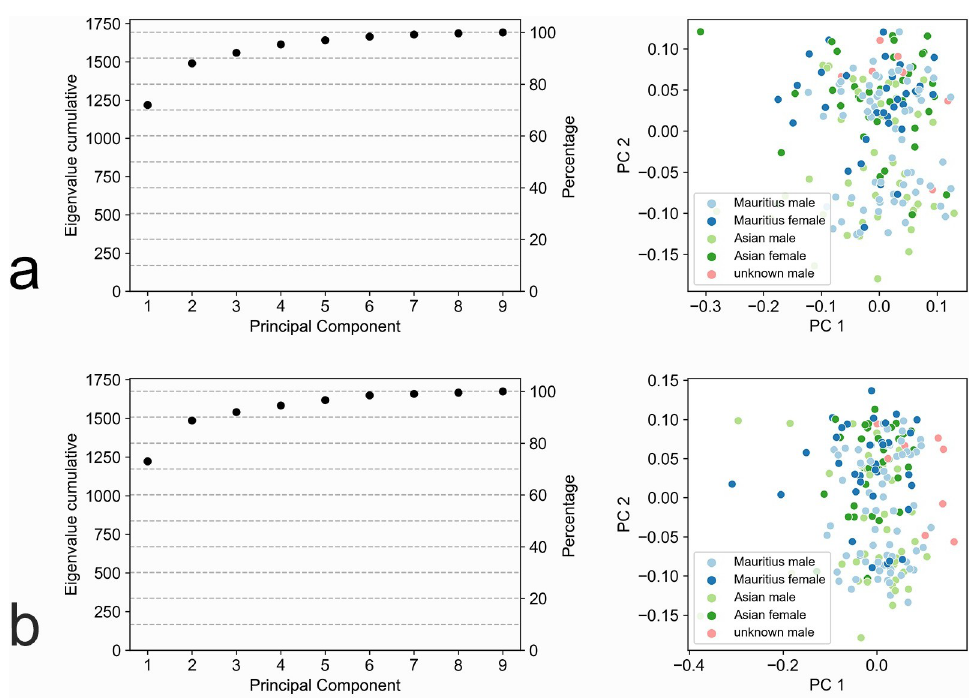
Fig 5. Principal Component Analysis (PCA) plots of choroidal volumes S1 –S9. (a) and (c) are scree plots showing the cumulative eigenvalues of the nine principal components (PCs) for right and left eyes, respectively. Eigenvalues indicate the explained variability of the respective PC. The first two PCs explain 88.1% and 88.8% of the variability in right and left eyes, respectively. (b) and (d) show projections of the data onto the first two principal components for right and left eyes, respectively.